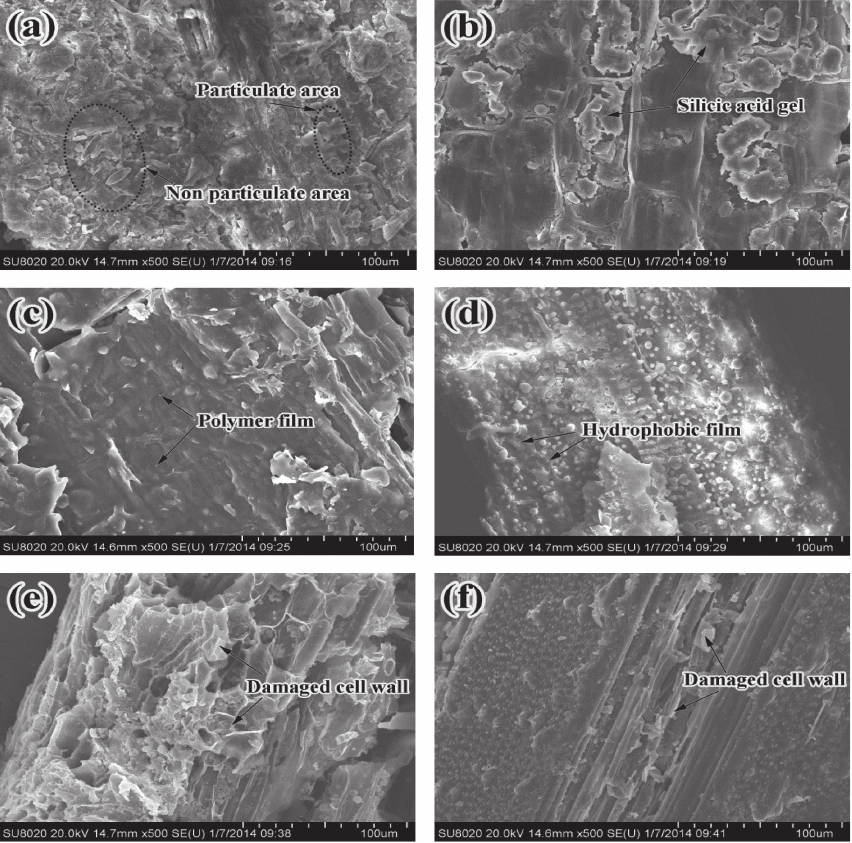
Figure 2: SEM images of straw fibers (500